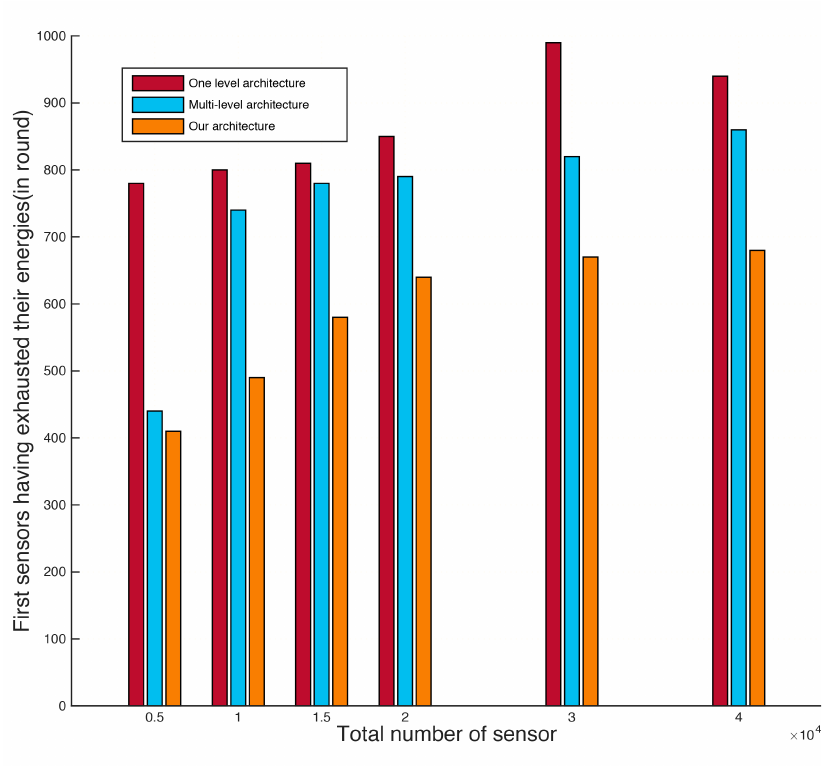
Figure 10. Instant of the first sensors having exhausted their energy following the